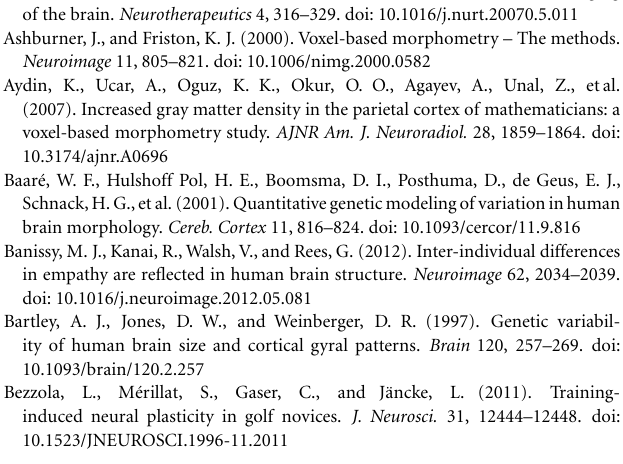
gene-environment correlation (B), whereby genes influence individual differences in the types of environment we are exposed to and in turn brain